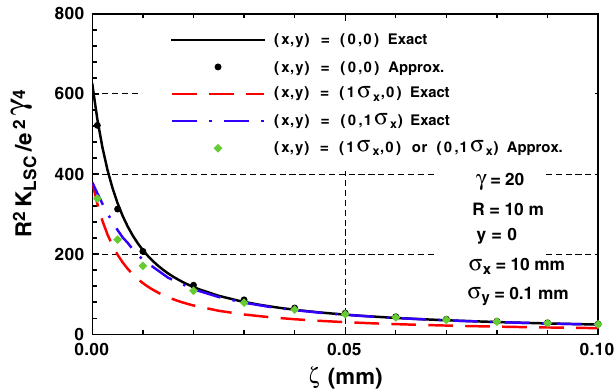
FIG. 5. (Color) Comparison between the approximation of Eq. (31) and an exact integration of Eq. (26) for a beam with